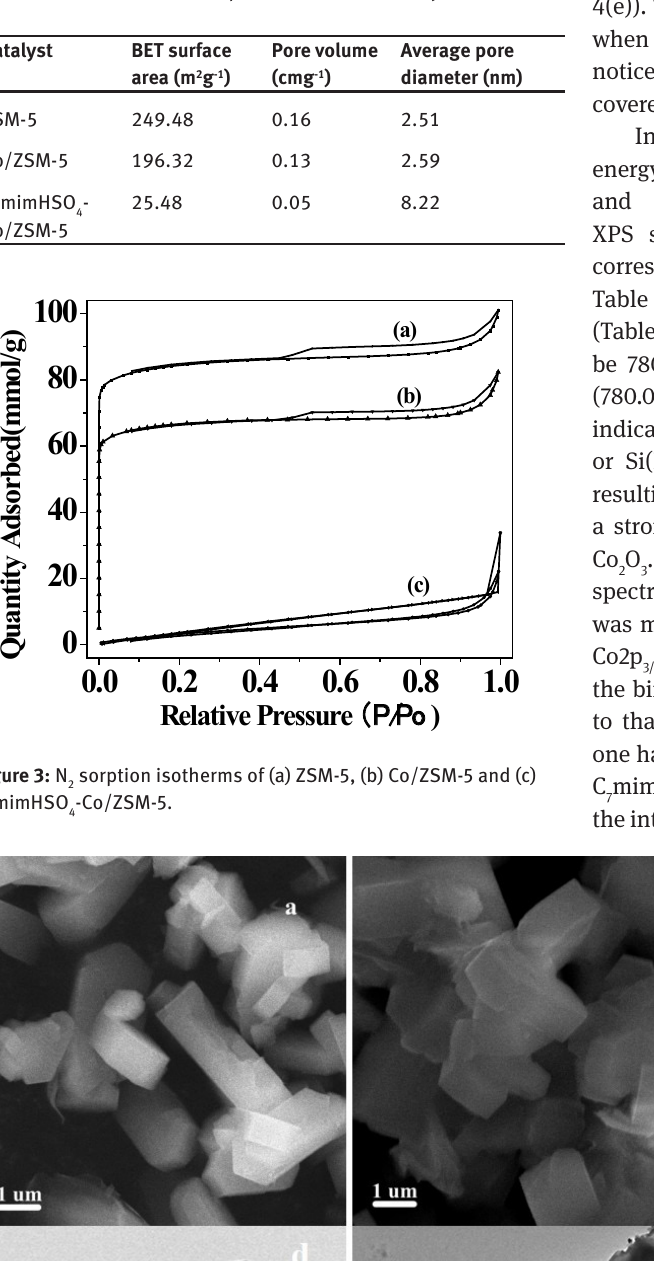
Figure 4: SEM and TEM images of (a, d) ZSM-5, (b, e) Co/ZSM-5 and (c, f) C